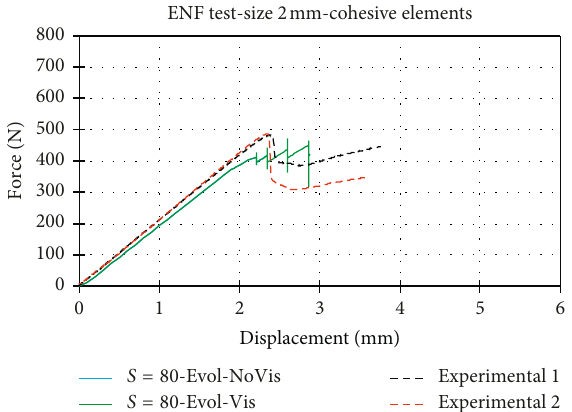
Figure 24: ENF test: cohesive element approach (element size 2mm).